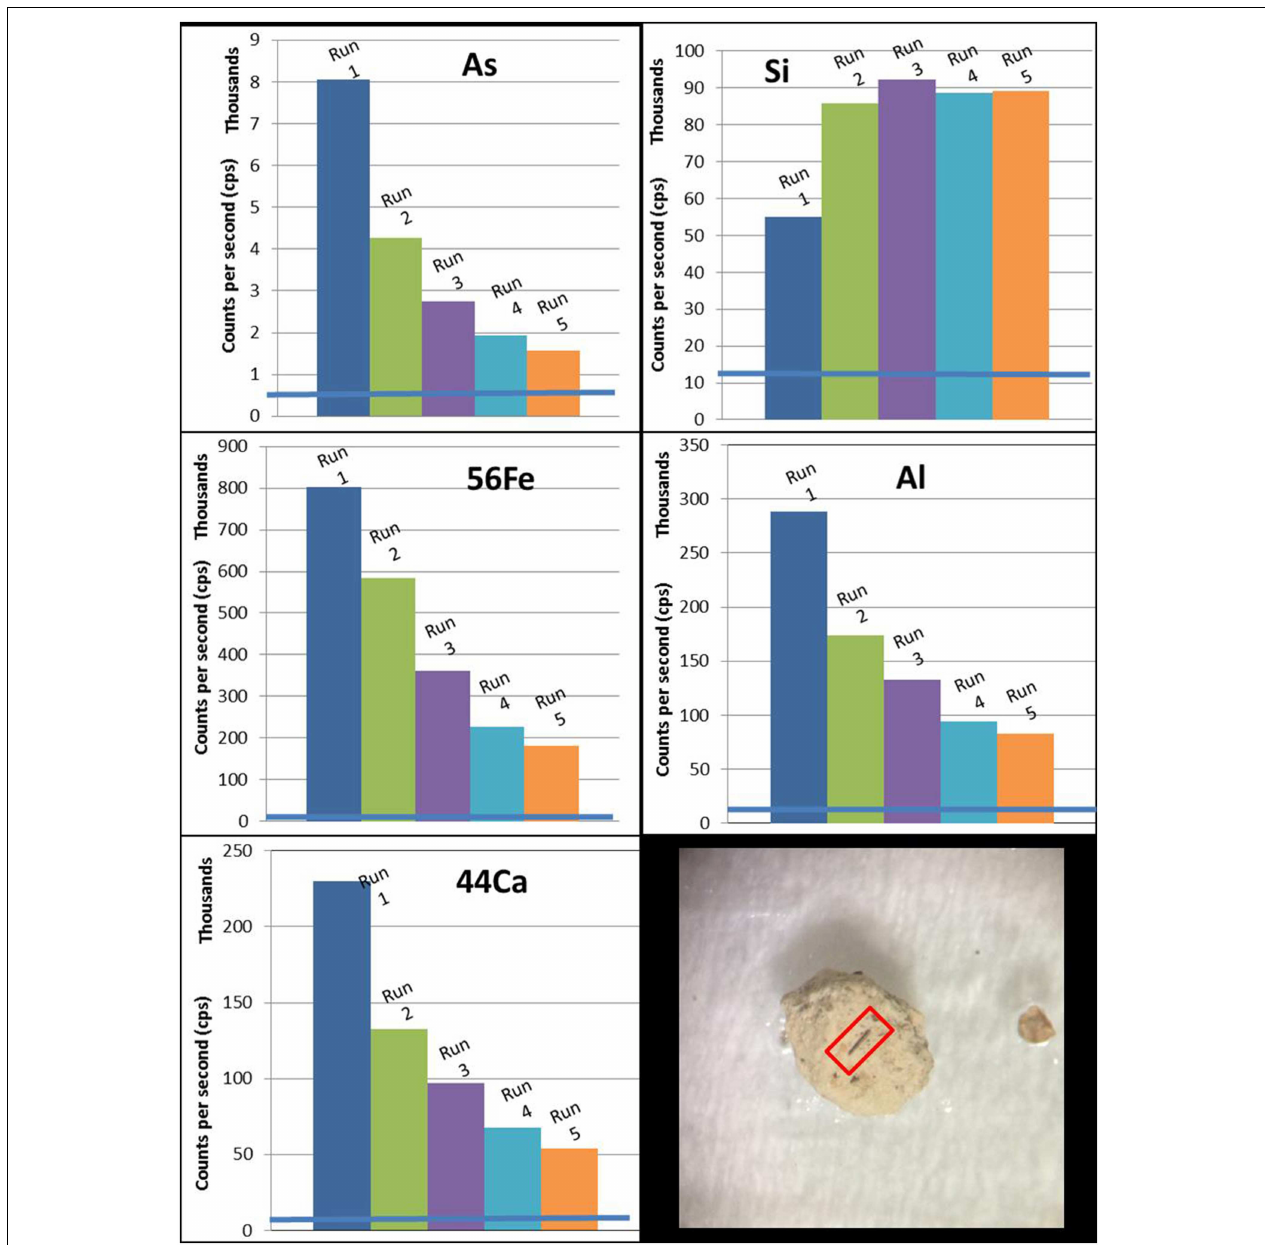
FIGURE 4 | LA-MS count per second (cps) graphs for the “coated” CNG 110 grain for As, Fe, Al, Ca, and Si. Also included is a picture of the grain, with a red box around the ablation site. The ablation site was approximately 0.5mm in